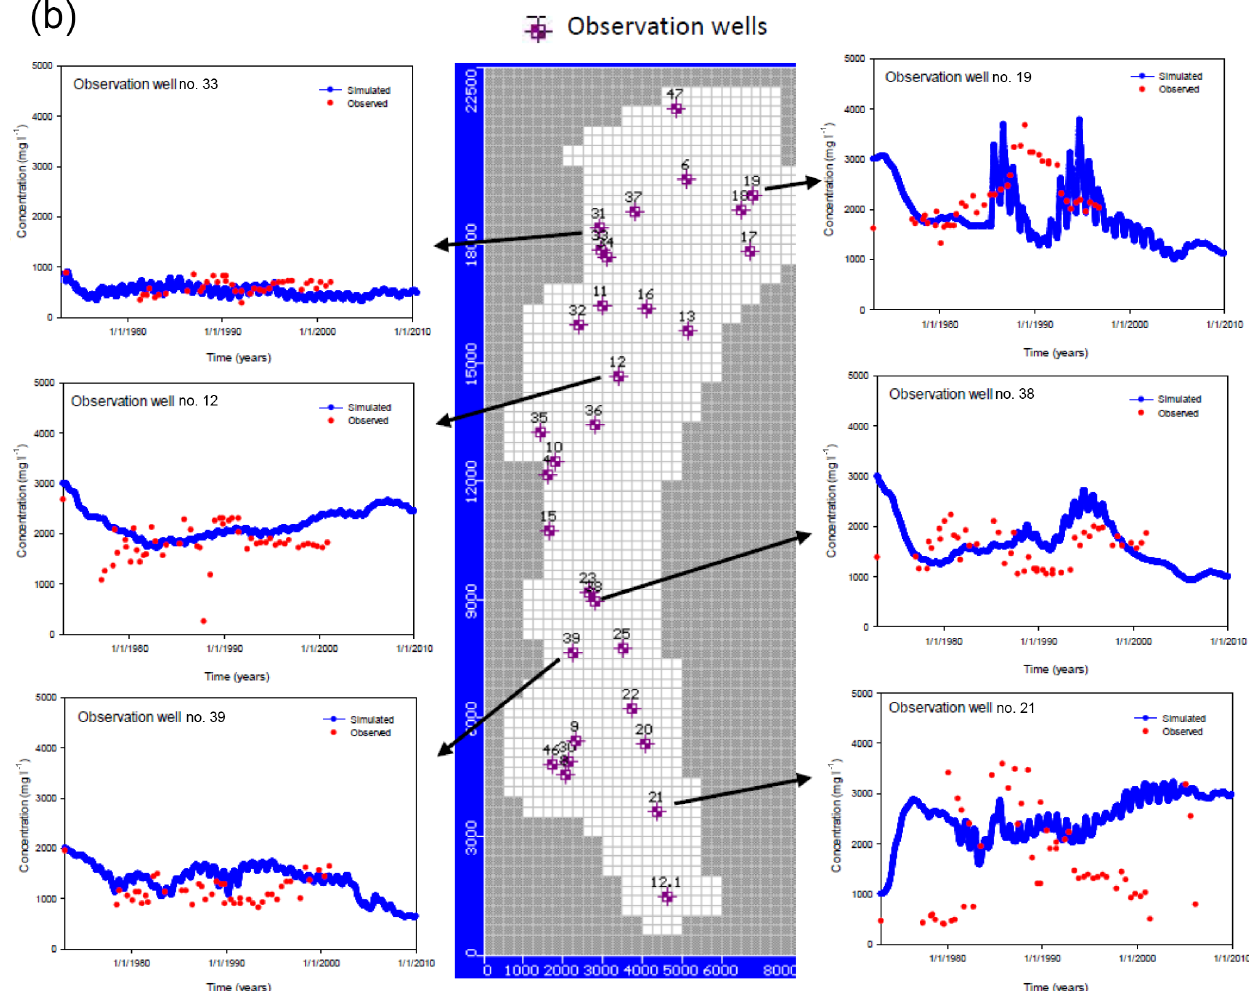
Figure 11. (a) Hydraulic head obtained with the models vs. data at some observation points. (b) Salinity obtained with the models vs. data at some observation